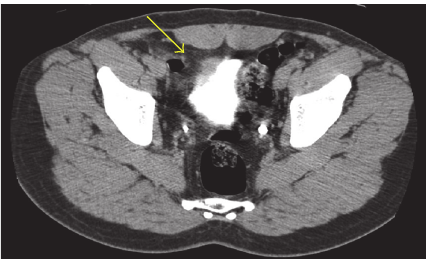
Figure 4: CT-scan of the second case showing a bladder wall thickening, with contrast